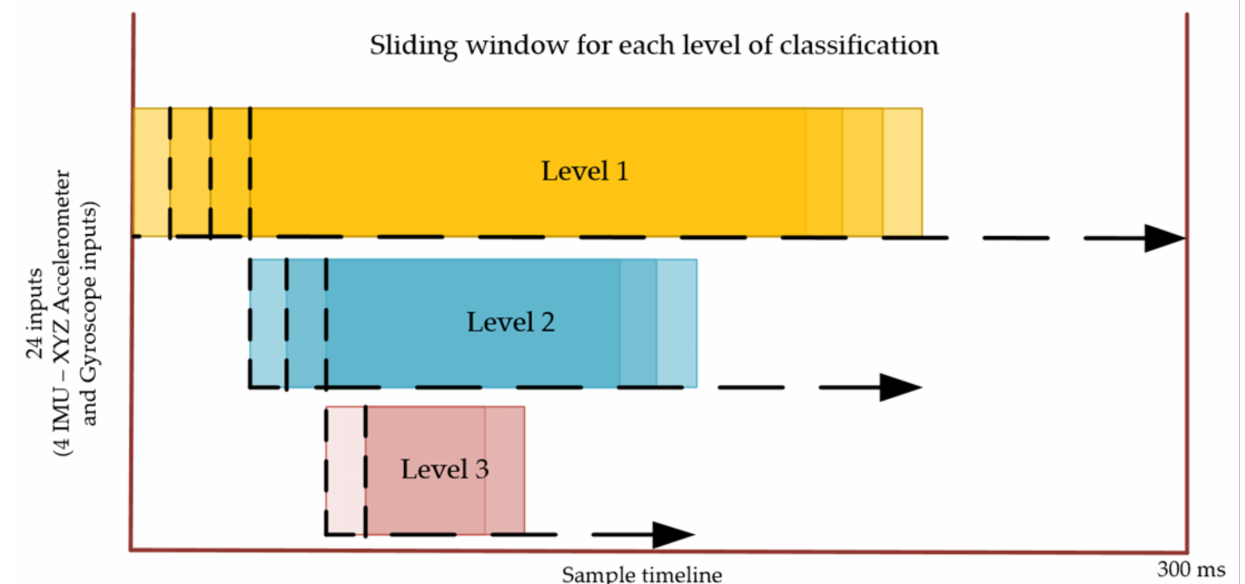
Figure 5. Illustration of the segmented window sliding in 10 ms increments for each level of classification. Level 1—200 ms; Level 2—100 ms; Level 3—40